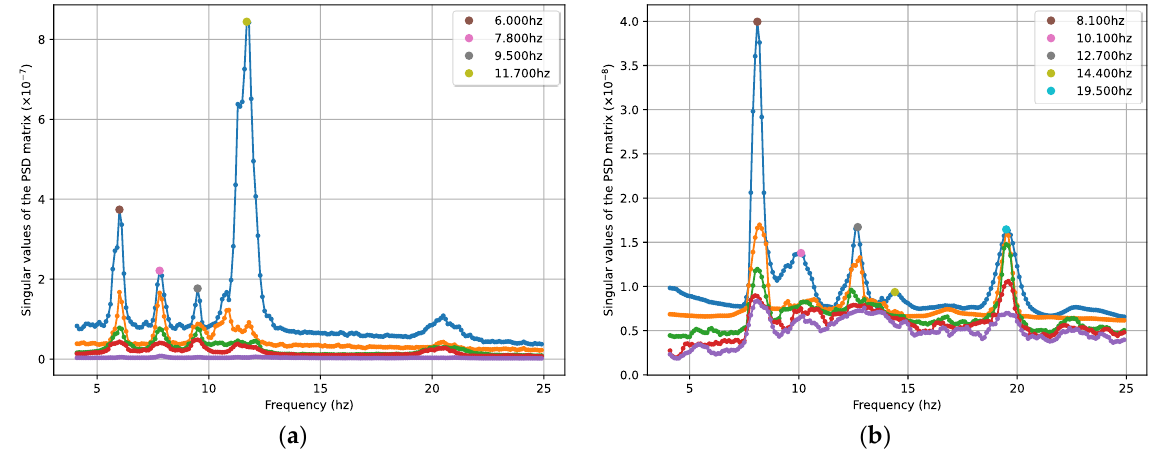
Figure 7. Modal identification by FDD: ( a ) Seolmun Bridge; ( b ) Gajwa Bridge.